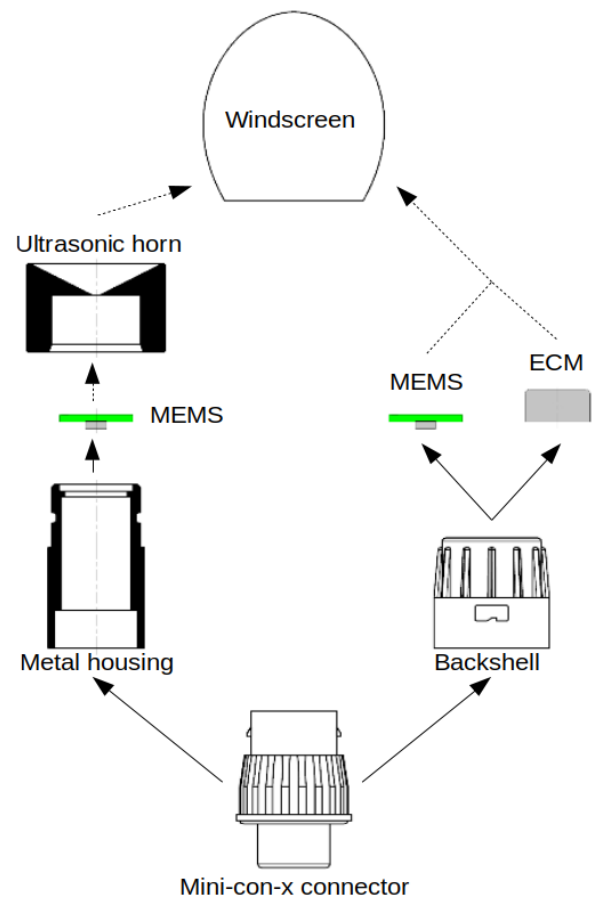
Figure 9. General Sonitor microphone design, showing all parts except the wiring. Optional combinations are shown with dotted